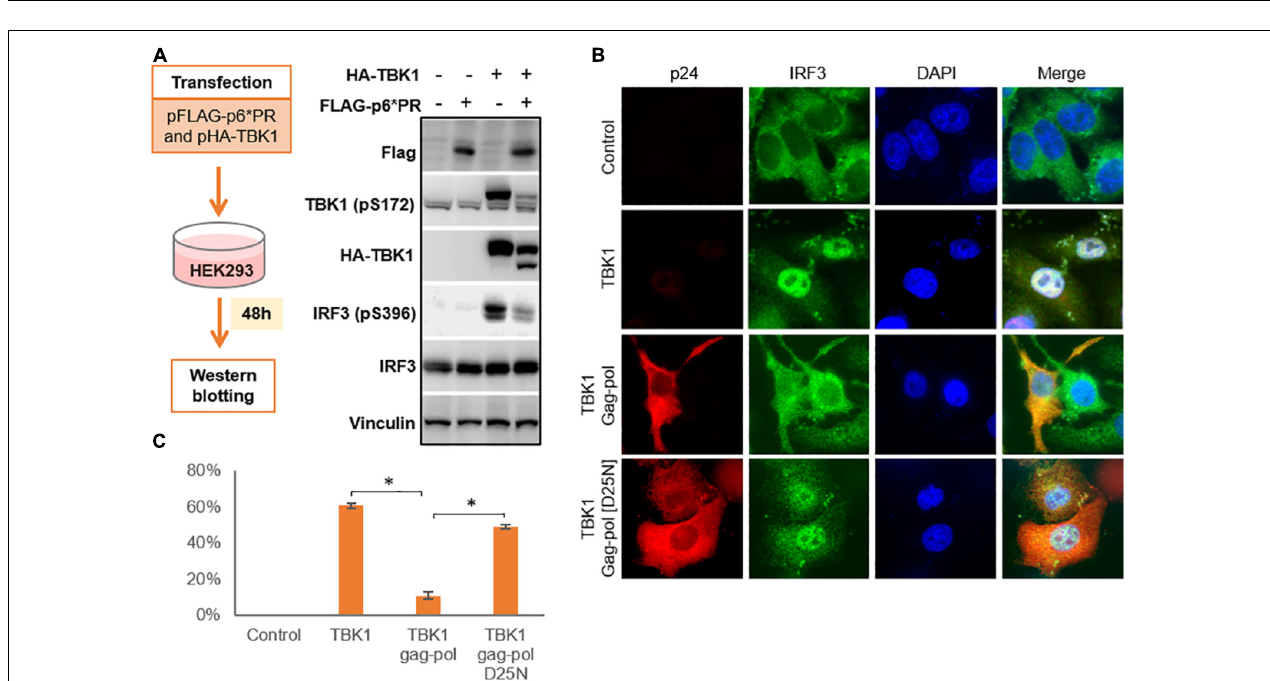
FIGURE 4 | HIV-1 protease inhibits IRF3 phosphorylation and regulates its localization. (A) pFLAG-p6*PR and pHA-TBK1 were co-transfected into HEK293 cells and western blot was done after 48 h. Total TBK1, phosphorylated TBK1, total IRF3 and phosphorylated IRF3 were observed with corresponding antibodies. (B) Cells co-transfected with TBK1 and wild type Gag-pol or its enzymatically inactive mutant D25N for 48 h after which cells were collected and fixed in paraformaldehyde. Immunofluorescence staining done for gag-pol with AlexaFluor 568 and IRF3 stained with AlexaFluor 488 which emitted red and green fluorescence, respectively. Nucleus stained blue with DAPI. Control represents non-transfected cells. (C) Percentage of IRF3 activation was calculated from the IRF3 panel of Figure 4B depicting the number of cells containing IRF3 translocated into the nucleus over total cells in the field. Data represents the mean value obtained from counting three fields containing at least 20 cells in each field. ∗ indicates p -value <